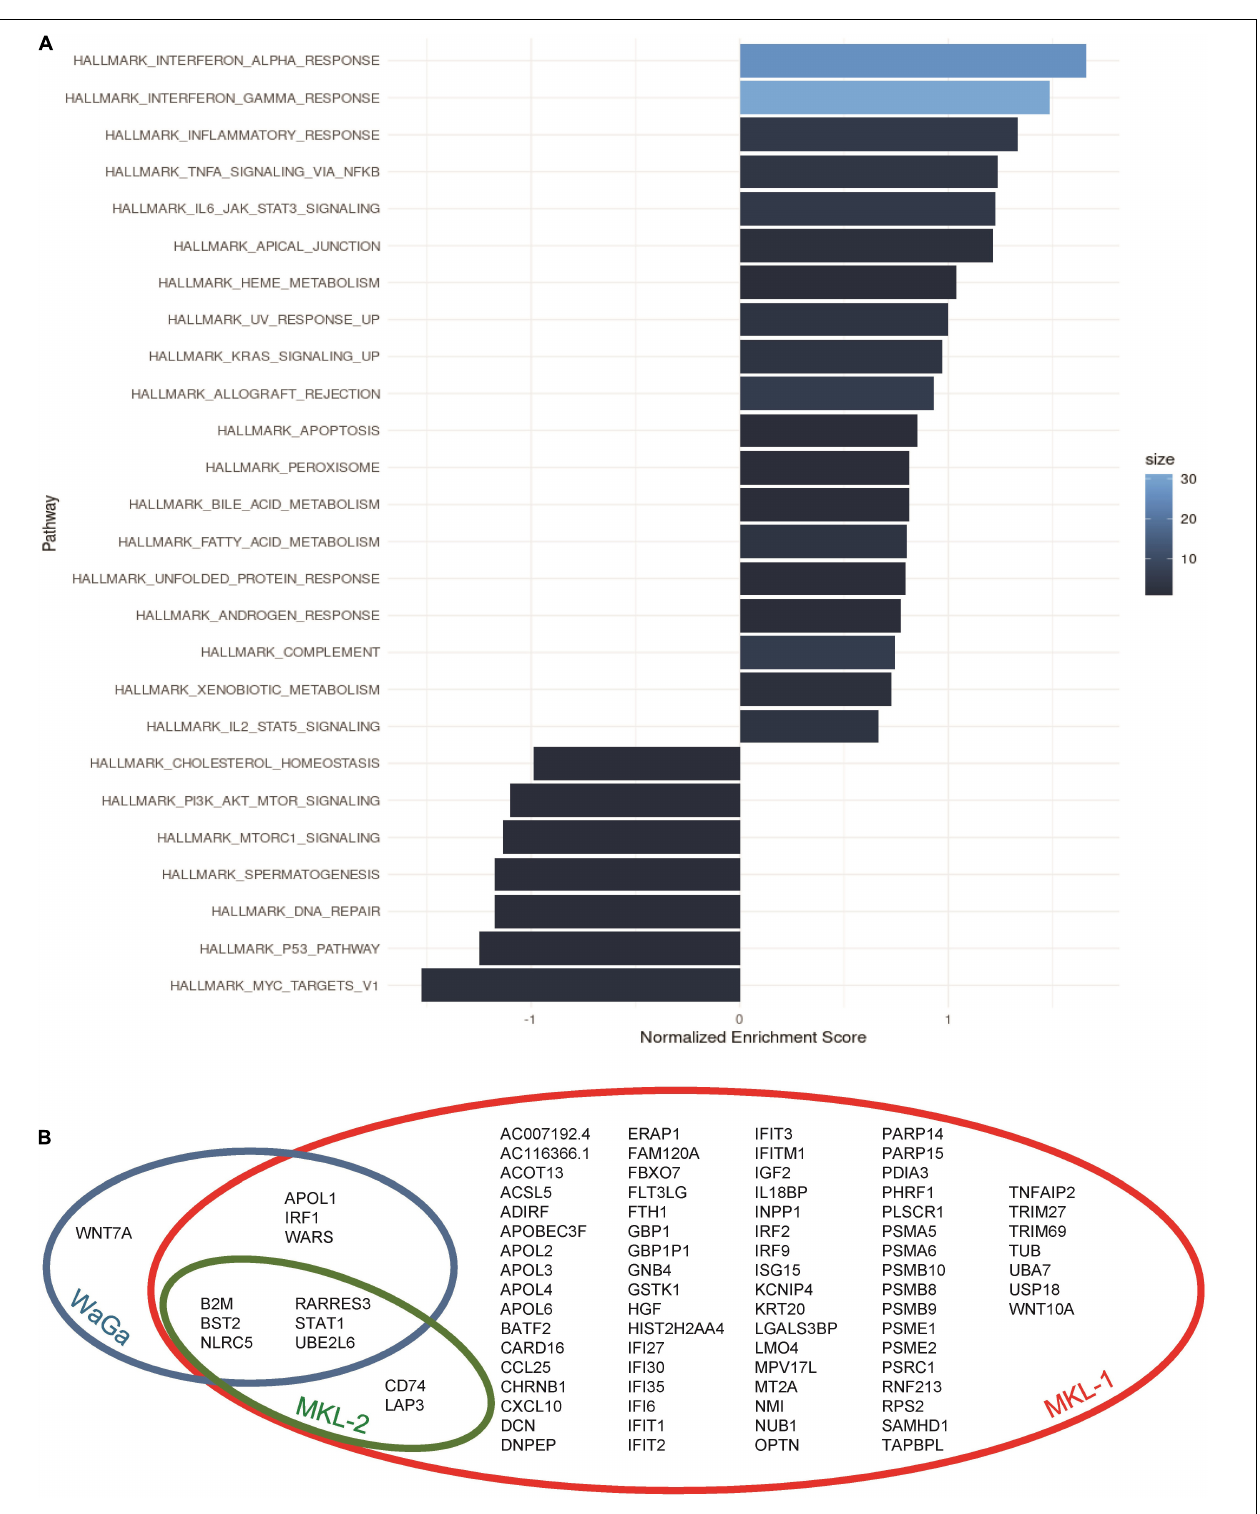
FIGURE 3 | Pathway annotation and distribution of differentially expressed genes. (A) Hallmark pathway enrichment analysis of all used MCC cell lines (MKL-1, MKL-2, and WaGa): Data were pooled for the three cell lines in one plot. Gene set enrichment analysis was performed using the Bioconductor package fgsea with the immune signature hallmarks by Molecular Signatures Database. Size corresponds to gene count of how many expressed genes from the input overlap with the pathway. (B) The Venn diagram of the three cell lines gives an overview over shared differentially expressed genes between the cell lines MKL-1 (red circle), MKL-2 (green circle), and WaGa (blue